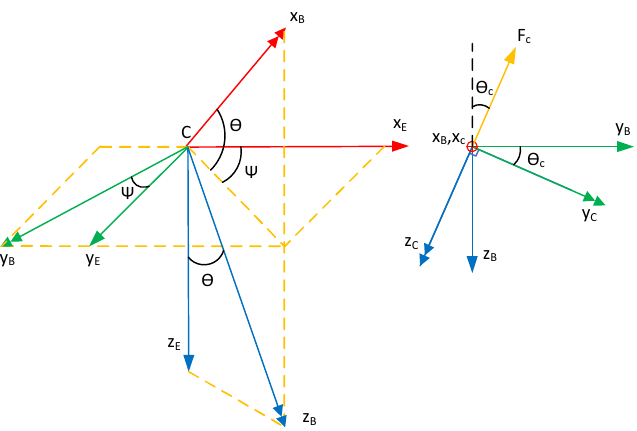
Figure 2. Earth, BFP and Canard Frame.